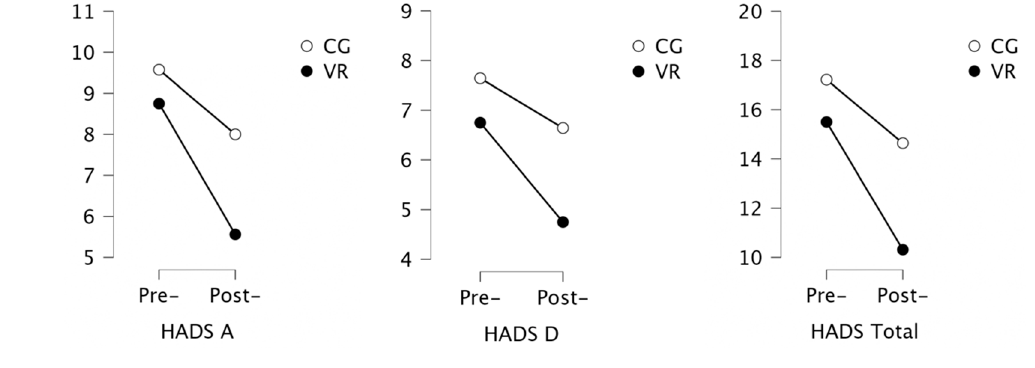
Figure 4. Results of the analysis of anxiety and depression.